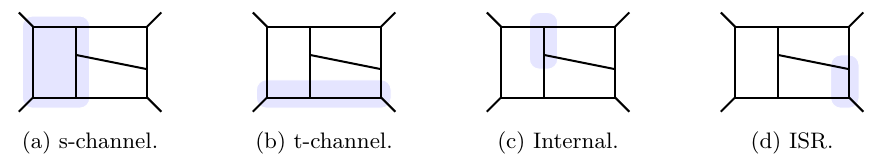
Figure 1. Pictorial representation of thresholds for a 2 → 2 diagram. Highlighted in blue are the vertex sets s , corresponding to subgraphs of the original graph. The complement of each subgraph corresponds to a threshold of the same